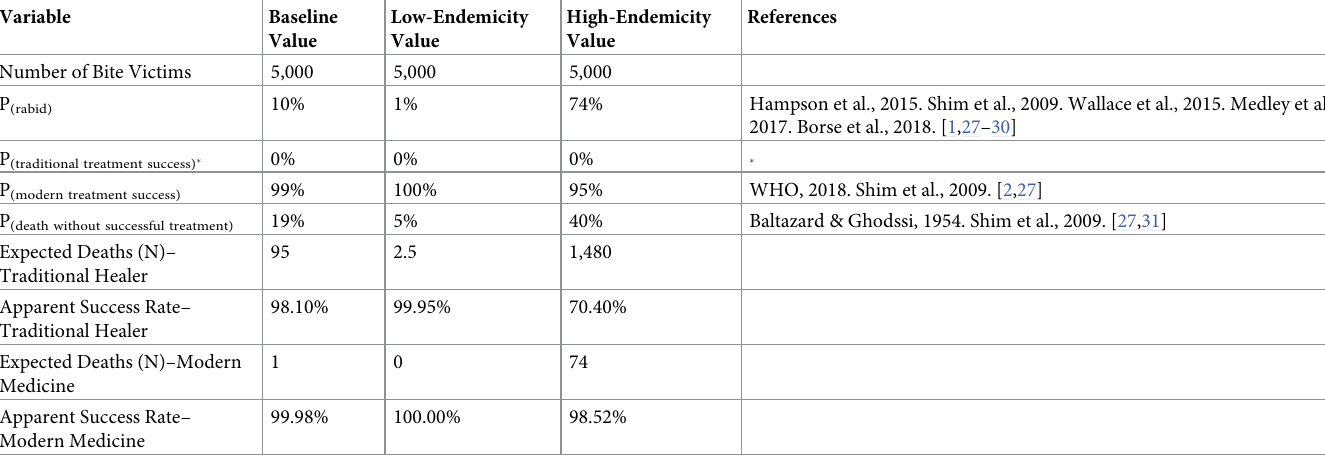
Table 4. Probabilities of rabies deaths and treatment apparent success rates for rabies exposures by traditional medicine and modern medicine scenarios.